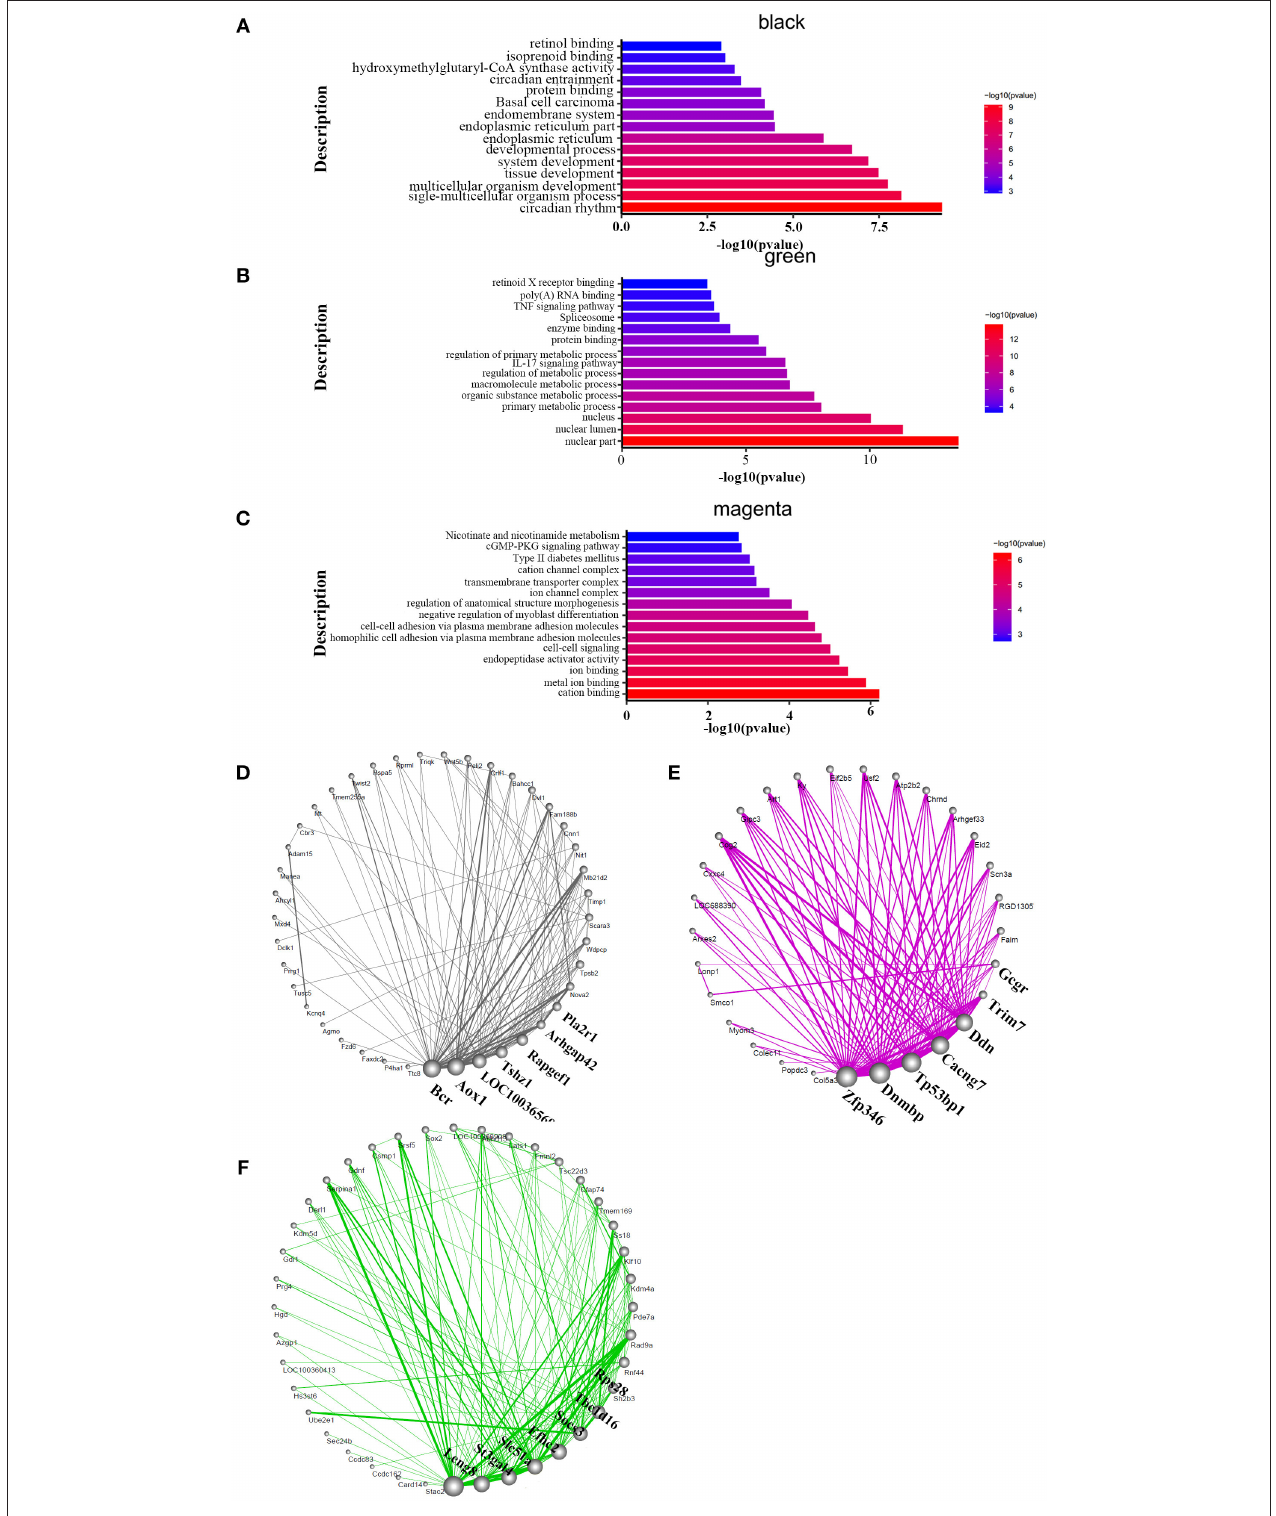
FIGURE 3 | Functional enrichment analysis and hub molecular identification of co-expression networks based on RNA-seq data. (A–C) Biological functions enriched in organ-specific modules. Bar length indicates the –log 10 of the P -value from the Fisher’s exact test. Edge width represents connectivity strength. (D–F) Organ-specific co-expression hub networks. Edge width represents connectivity strength. Node size represents the level of hubness.